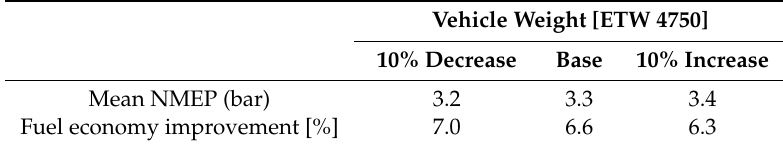
Table 5. Summary of fuel economy improvement by weight change in FTP-75.